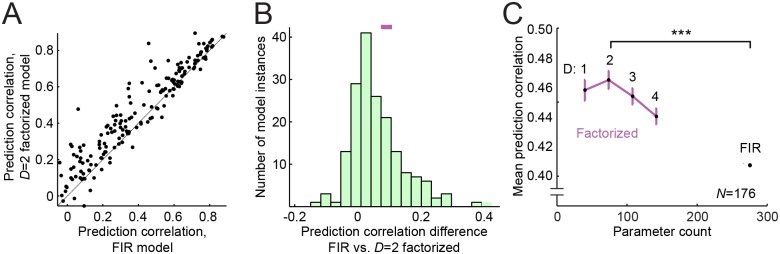
Factorized model performance.
A. Scatter plot of D = 2 factorized- versus FIR model prediction correlation per neuron shows that the factorized model predicts more accurately for most neurons. B. Histogram of difference in prediction correlation D = 2 factorized and FIR models for each neuron. Error bar at top shows 1 SEM on the difference between model predictions, illustrating the procedure for measuring error bars in the comparisons of average model performance that follow (see Methods). C. Pareto plot compares model complexity (parameter count) versus mean prediction correlation for the FIR model and factorized models, plotted as in Fig 2 (channel count, D = 1…4). Error bars calculated as in B, relative to the FIR STRF. Despite having fewer parameters, the factorized models perform consistently better than the FIR (p < 0.001, sign test, N = 176). The D = 2 factorized model performs best, with about a 15% average increase in correlation over the FIR STRF, despite requiring about one-quarter of the parameters.